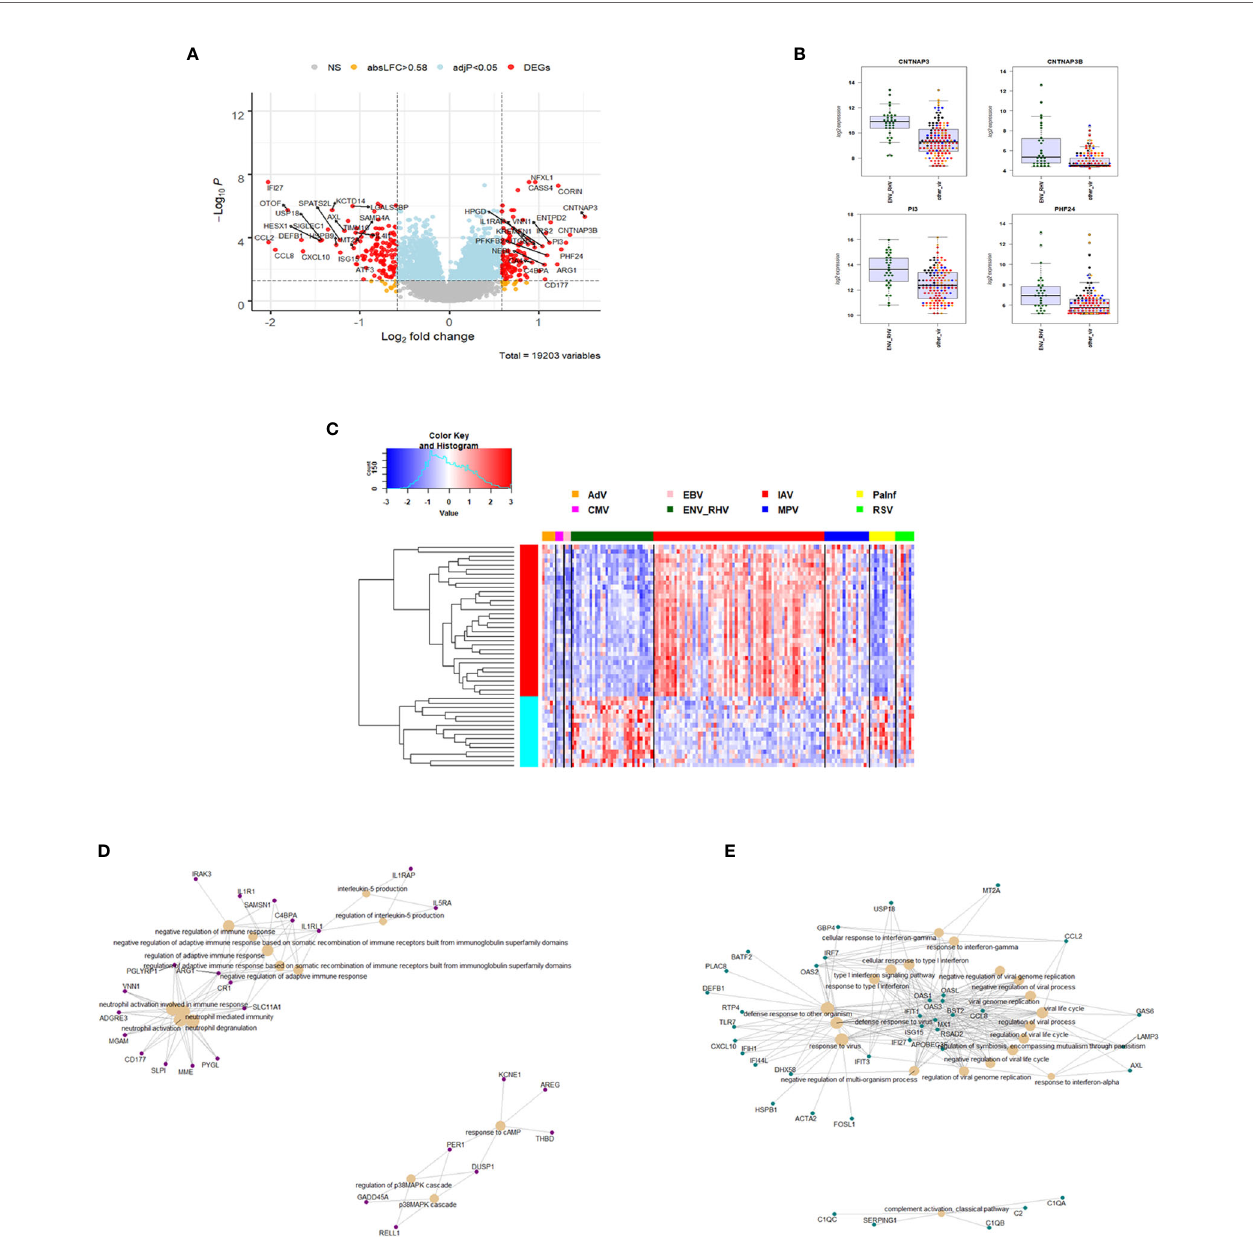
FIGURE 5 | Responses in ENV versus other respiratory infections. (A) Volcano plot of results of the contrast from the linear regression analysis of ENV infected versus all other respiratory virus infections. y-axis: -log 10 BH multiple testing adjusted p-values, x-axis: log 2 fold change. DEGs (absolute log-fold change > 1.5, corresponding to a log 2 -fold change > 0.58; multiple testing adjusted p-value < 0.05) are colored red and the top 20 up- and down-regulated (by log-fold change) DEGs are labeled. Blue: genes with adjusted p-value < 0.05. (B) Gene expression levels of the top four most strongly up-regulated (by absolute fold-change) ENV versus all other respiratory virus speci fi c DEGs. CNTNAP3 , Contactin Associated Protein Family Member 3; CNTNAP3B , Contactin Associated Protein Family Member 3B; PI3 , Peptidase Inhibitor 3; PHF24 , PHD Finger Protein 24. IAV, in fl uenza; ENV_RHV, enterovirus/rhinovirus; MPV, human metapneumovirus; other_vir, all other respiratory viruses; hlty_contr, healthy controls. (C) Expression levels of the top 50 most strongly regulated (by absolute fold-change) DEGs from the contrast of ENV infected patients versus all other respiratory infections are presented. Values were scaled by row. red: up-regulated DEGs, blue: down-regulated DEGS. IAV, in fl uenza virus; ENV_RHV, enterovirus/rhinovirus; MPV, metapneumovirus; PaInf, parain fl uenza virus; RSV, respiratory syncytial virus; AdV, adenovirus; CMV, cytomegalovirus; EBV , Epstein-Barr virus. (D) Functional analysis using GO term enrichment for the DEGs from the contrast of ENV infected versus all other respiratory virus infections. Network of top 20 up-regulated pathways and associated genes. Red: up-regulated. (E) Functional analysis using GO term enrichment for the DEGs from the contrast of ENV infected versus all other respiratory virus infections. Network of top 20 down-regulated pathways and associated genes. Green: down-regulated. NS, not signi fi